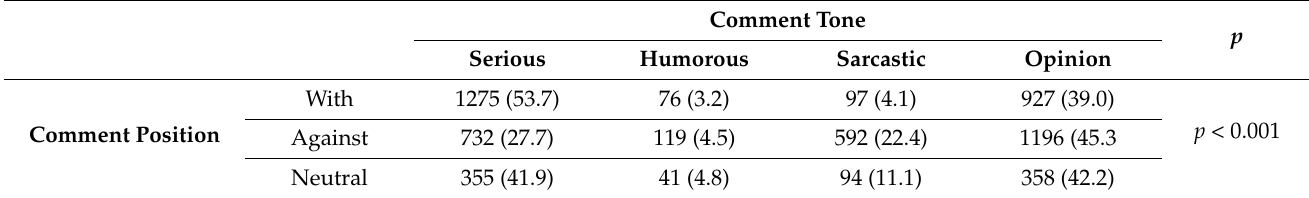
Table 5. Overall relation between comment tone and comment